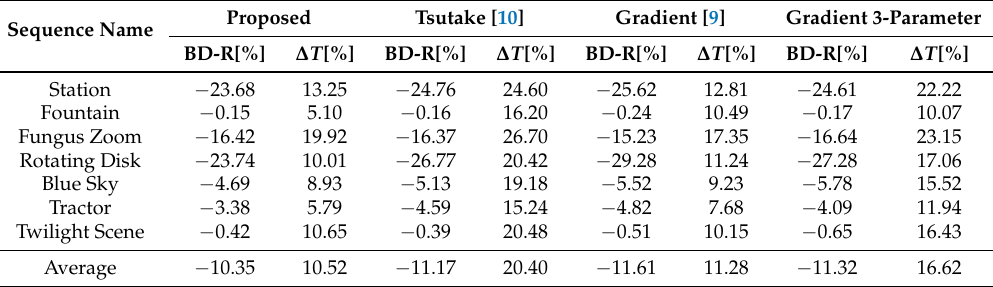
Table 5. Comparison of Coding Efficiency and Encoding Speed.